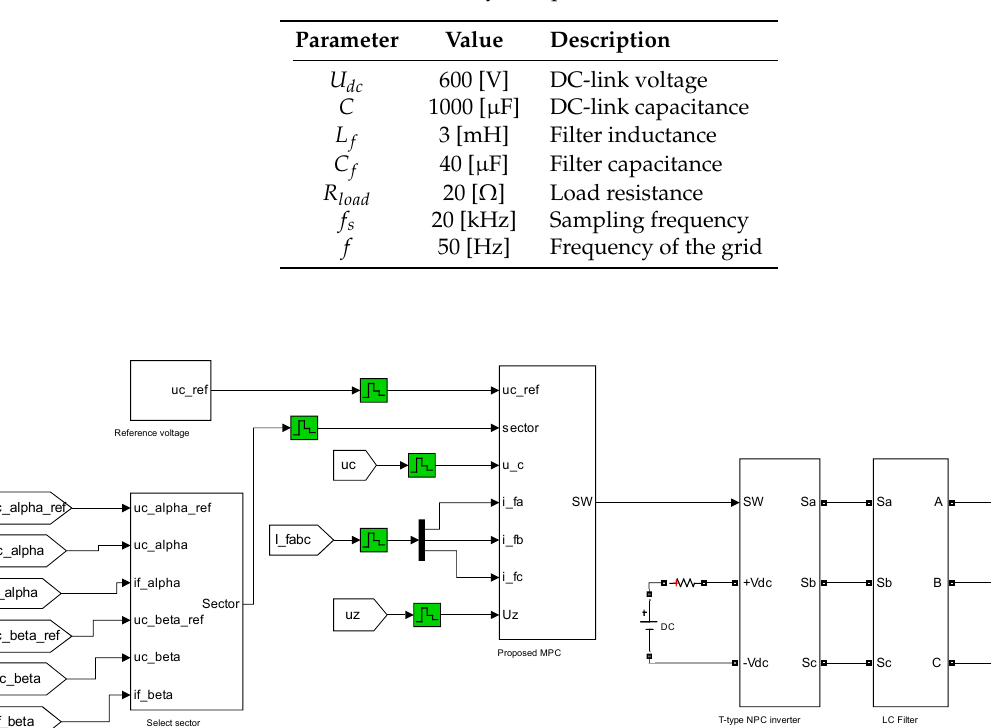
Table 3. System parameters.